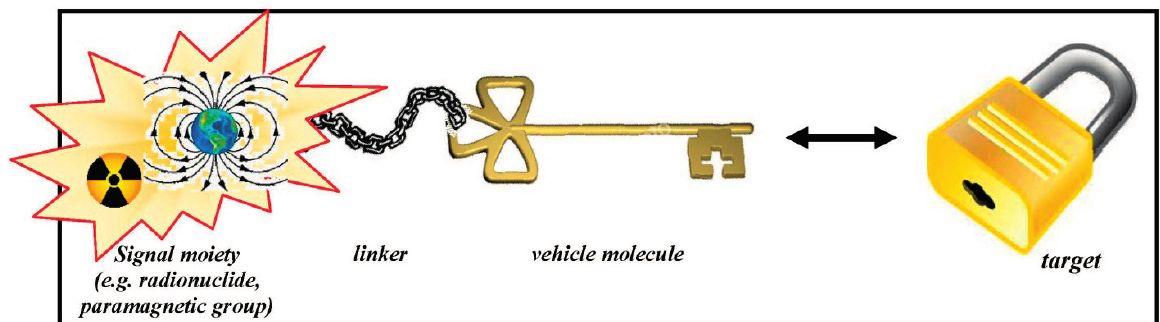
Figure 1. Schematic design of a molecular probe and its interaction with the target